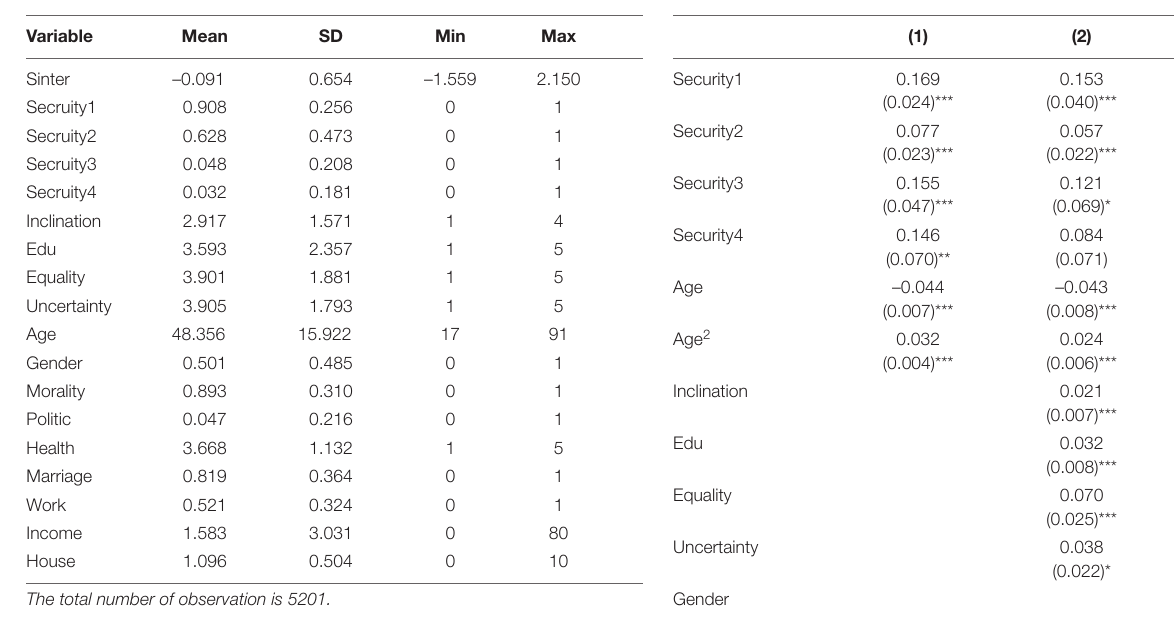
TABLE 3 | Descriptive analysis of main variables. TABLE 4 | The effect of social insurance on rural residents’ social